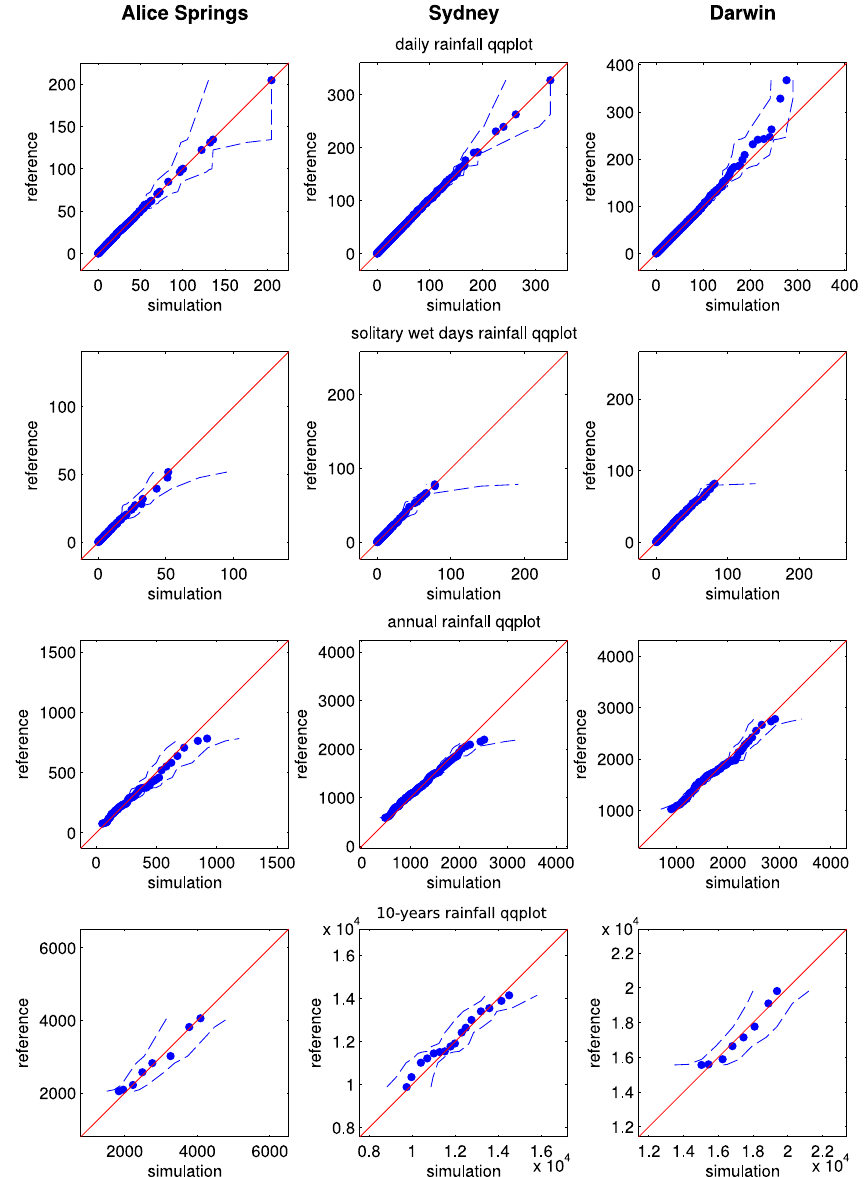
Figure 3. qq plots of the empirical probability rainfall amount (mm) distributions: median of the realizations (blue dots), 5th and 95th per- centiles (dashed lines). The bisector (solid line) indicates the exact quantile Fig. 3. qq-plots of the empirical probability rainfall amount [ mm ] distributions: median of the realizations (blue dots), 5th and 95th percentile (dashed lines). The bisector (solid line) indicates the exact quantile match.